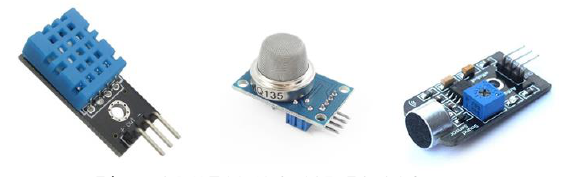
Figure 2 DHT11, MQ-135, FC-04